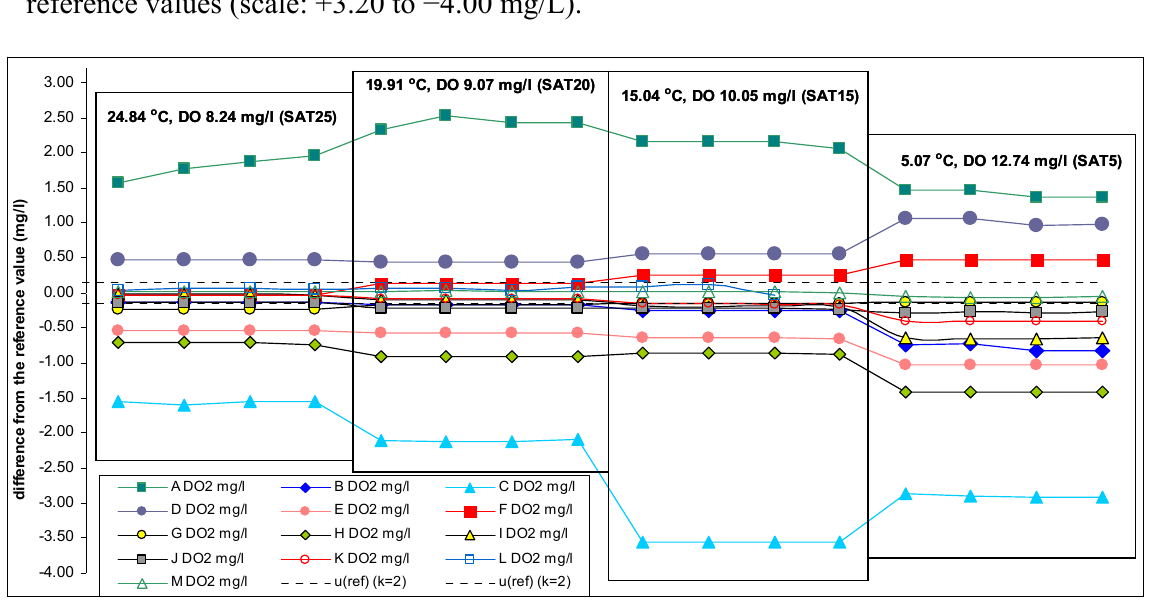
Scheme 2. Differences between DO readings of the participant instruments and the reference values (scale: +3.20 to − 4.00